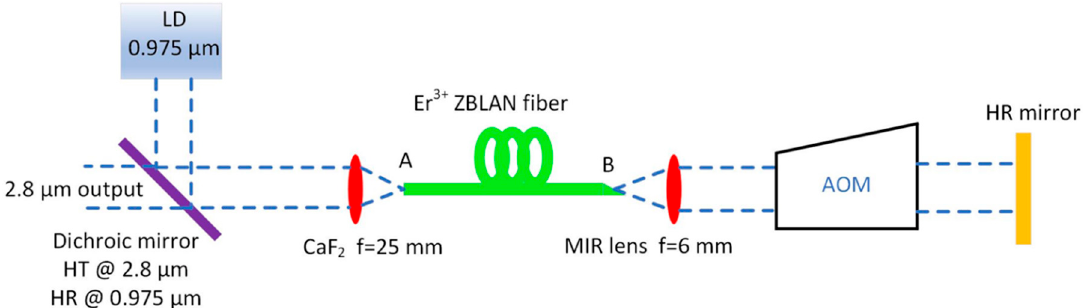
Figure 1. Schematic diagram of the Q-switched mid-infrared fiber laser (HR—highly reflective, HT—highly transmissive, LD—laser diode, AOM—acousto-optic modulator, and CaF 2 —calcium fluoride lens).